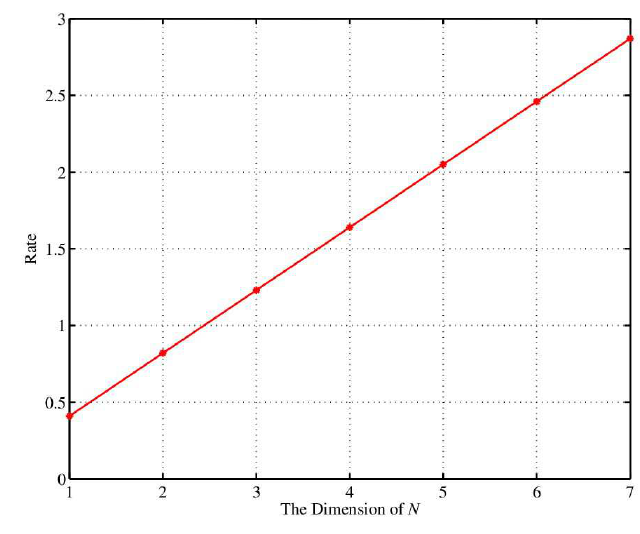
Figure 8. The change in the bit generation rate with the increase of